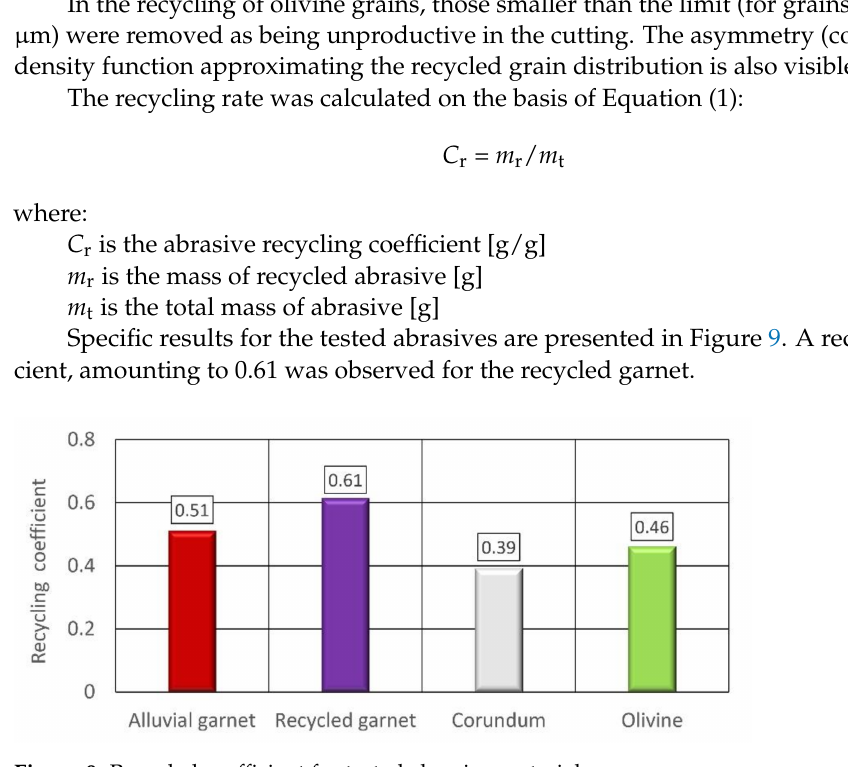
Figure 9. Recycled coefficient for tested abrasive